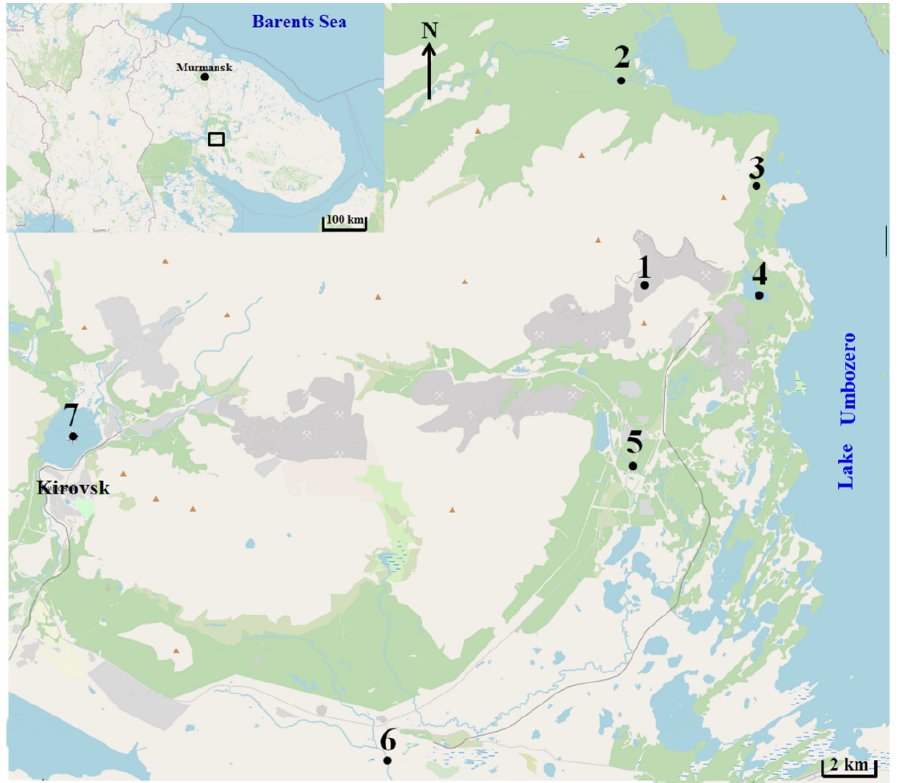
Figure 1. Sampling collection site map. 1. The Reindeer Creek plant; 2. The Tul’yok River; 3. The Teply Creek; 4. The Komarinoe Lake; 5. The Vuonnemyok River; 6. The Umbolka River; 7. Bolshoy Vudjavr Lake.